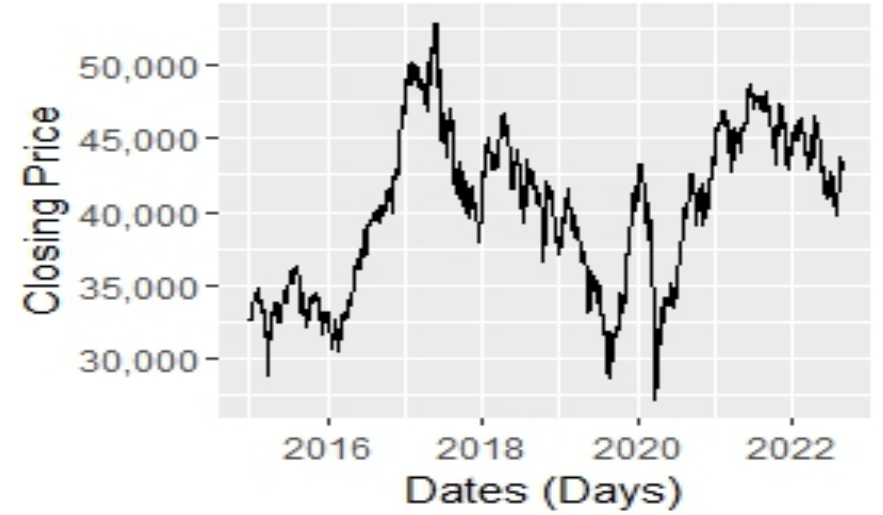
Table 2. Descriptive statistics of yearly KSE-100 index closing price.